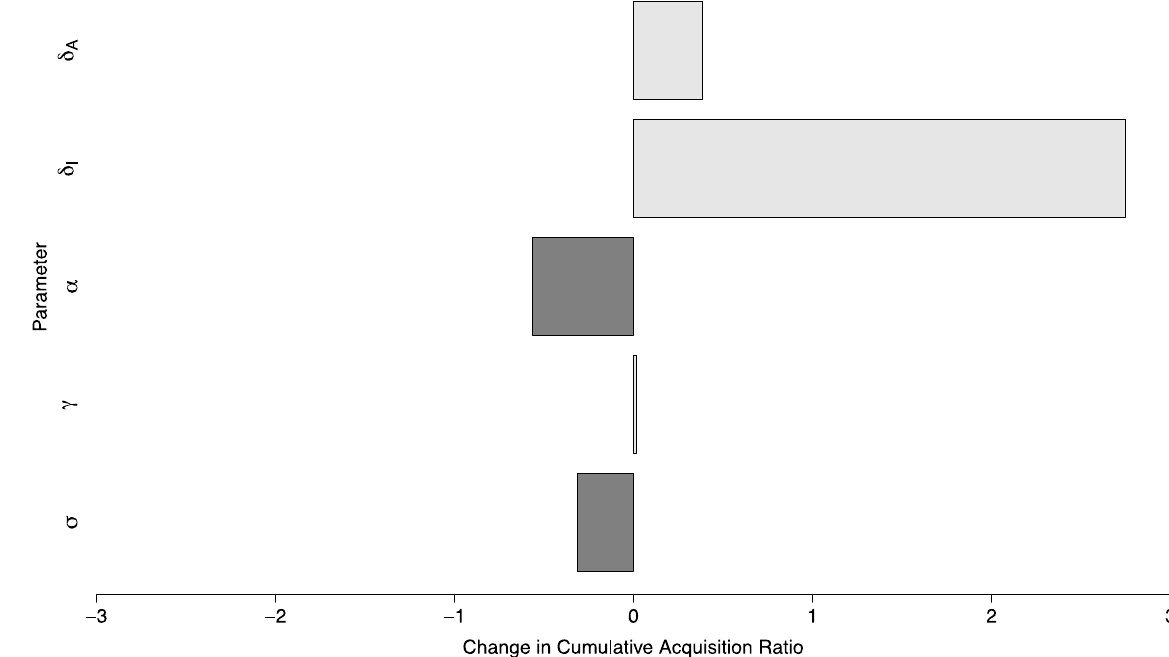
Figure 6. Distribution of cumulative COVID-19 cases in 1000 simulated university campuses with uncontrolled epidemics, comparing a campus with no in-person sporting events to two scenarios where visitors come from a high prevalence area and mix with the campus community at a low rate or a high rate, respectively.